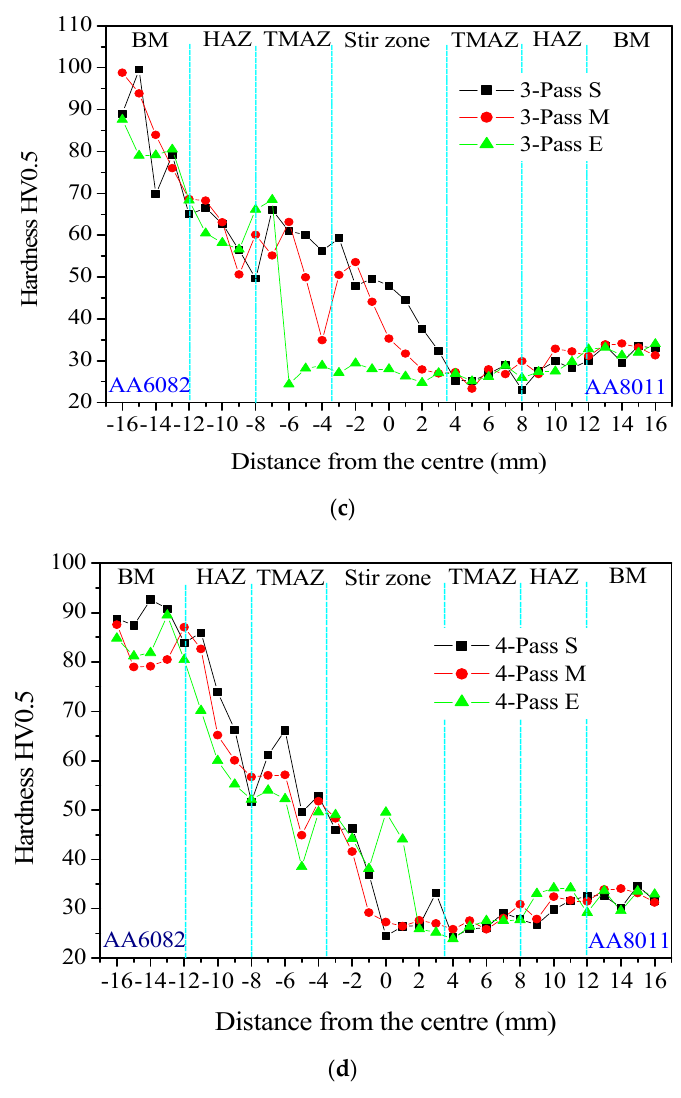
Figure 8. SFSP Hardness profiles, ( a ) 1-pass, ( b ) 2-pass, ( c ) 3-pass and ( d ) 4-pass.